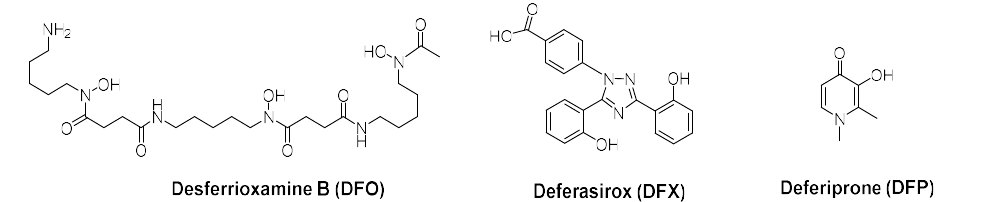
Figure 1. Iron chelators in clinical use: desferrioxamine B (DFO), deferasirox (DFX) and deferiprone (DFP).